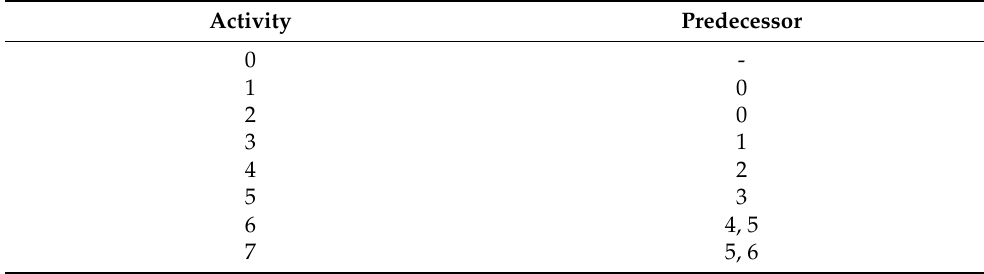
Table 1. The precedence relationships of the example with six